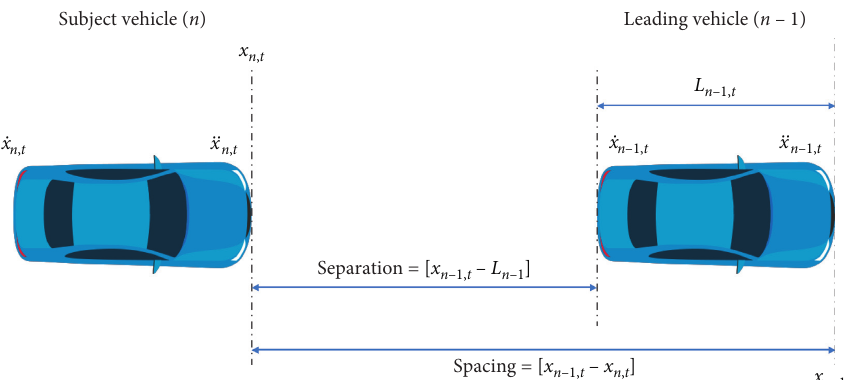
Figure 3: Car-following model notations.